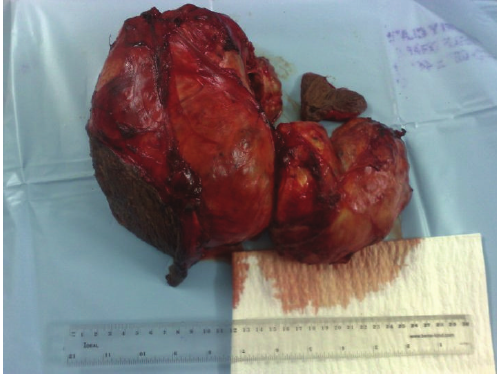
Figure 2: Specimen of the